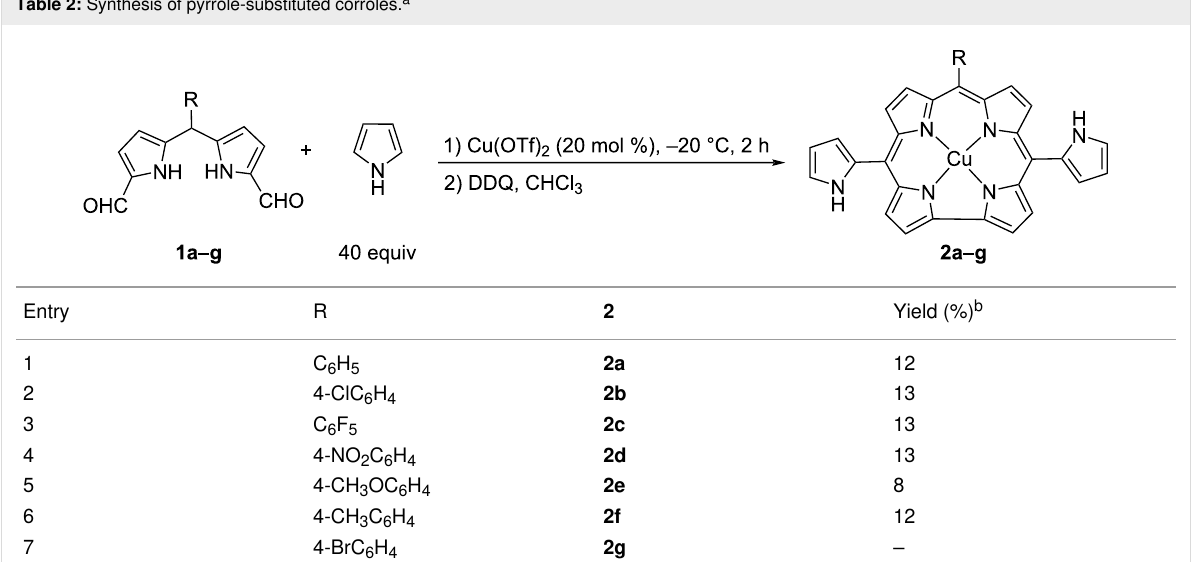
Table 2: Synthesis of pyrrole-substituted corroles.